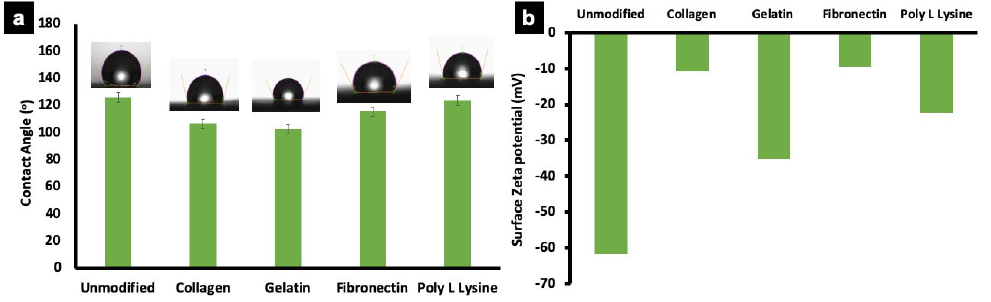
Figure 5. Wettability and zeta potential of unmodified PLLA scaffold and ECM protein surface functionalized PLLA scaffolds. ( a ) Representative average contact angle of unmodified PLLA scaffolds and protein functionalized scaffolds. The water contact angle of unmodified and poly L lysine was relatively similar. However, the collagen, gelatin and fibronectin modified fibers show a slightly reduced wettability behavior, possibly due to the inherent nature of individual proteins. ( b ) The graph represents average zeta potential of unmodified PLLA scaffold and protein functionalized scaffolds. The surface zeta potential of unmodified scaffolds was higher than other samples, with collagen and fibronectin scaffolds showing lowest values.